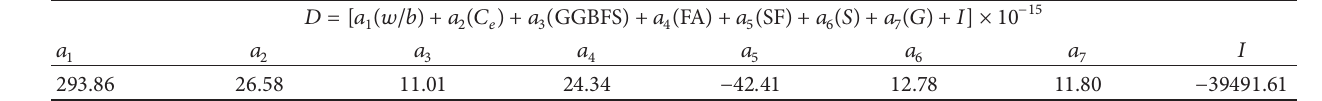
Table 5: Result of multiregression analysis.